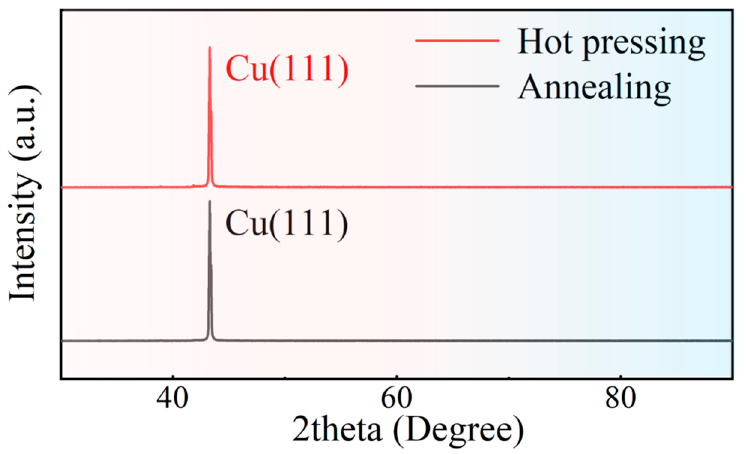
Figure 3. XRD tested the Miller indices of copper foil after annealing and copper block after hot pressing.